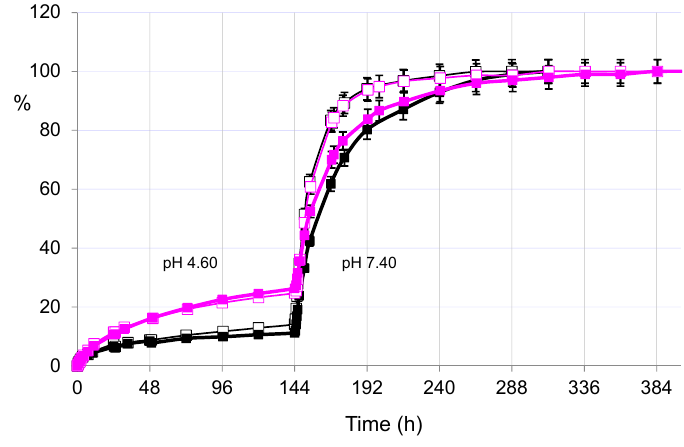
Figure 3. Releasing profiles (% in relation to time) of paroxetine (dark lines) and duloxetine (pink lines) from the hydrogel PHE-Nip3 with (empty squares) and without (filled squares) application of the alternating magnetic field (20 kHz/50 W). The release was performed at 25 °C in acetate (pH 4.60) and in PBS (pH 7.40) buffer solutions.